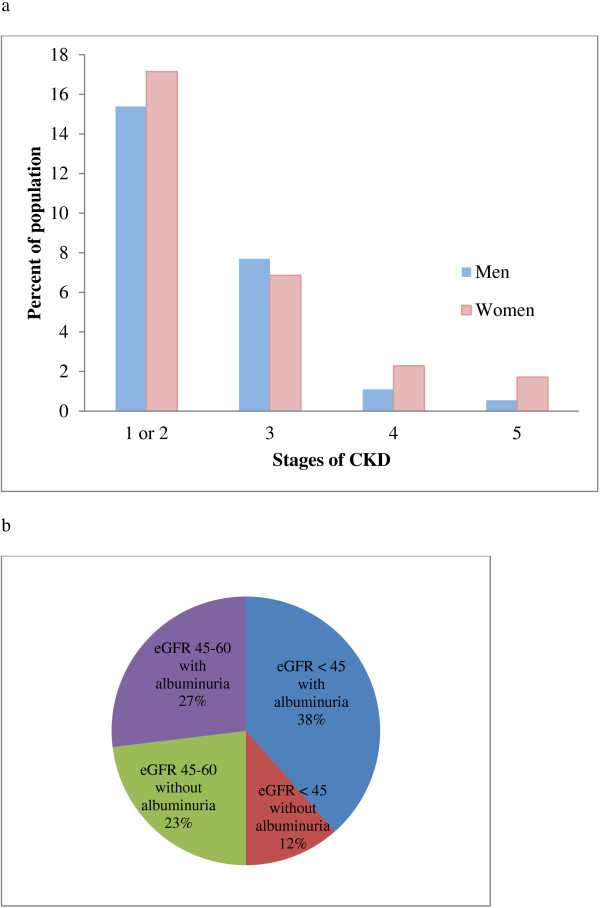
Stages of CKD with details on albuminuria for stage three CKD. a. Stages of CKD. Overall 94 (27%) of participants had CKD. Stage one or two CKD (albuminuria with eGFR > 90 or between 60–90 ml/min/1.73 m2) was present in 58 (62%). Stage five CKD was present in 4 (4%). Abbreviations: CKD-Chronic kidney disease, eGFR-estimated glomerular filtration rate. b. Characterizing stage three CKD. Among participants with stage three CKD (n = 26, 28%), 6 (23%) had an isolated reduction in eGFR between 45–59 ml/min/1.73 m2; all others had either stage 3b CKD or accompanying albuminuria. Abbreviations: CKD-chronic kidney disease; eGFR-estimated glomerular filtration rate.